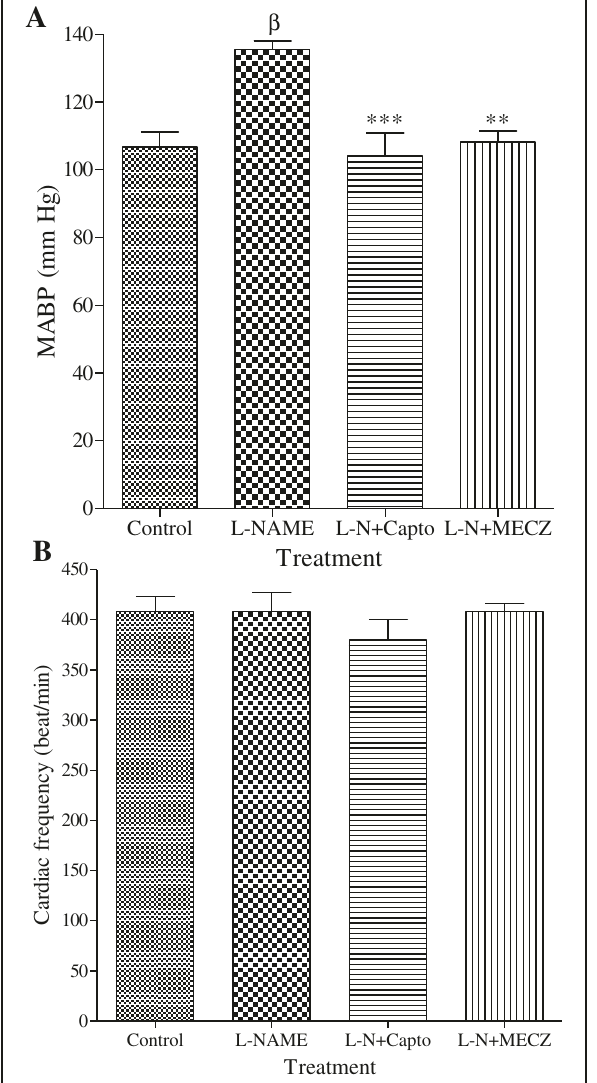
Figure 2 Effects of the methanol extract of Cinnamomum zeylanicum on MABP and heart rate (B). Values are Mean±SEM (n=5); β p<0.01 compared to the control group; **p<0.01 and ***p<0.01 compared to the L-NAME group.